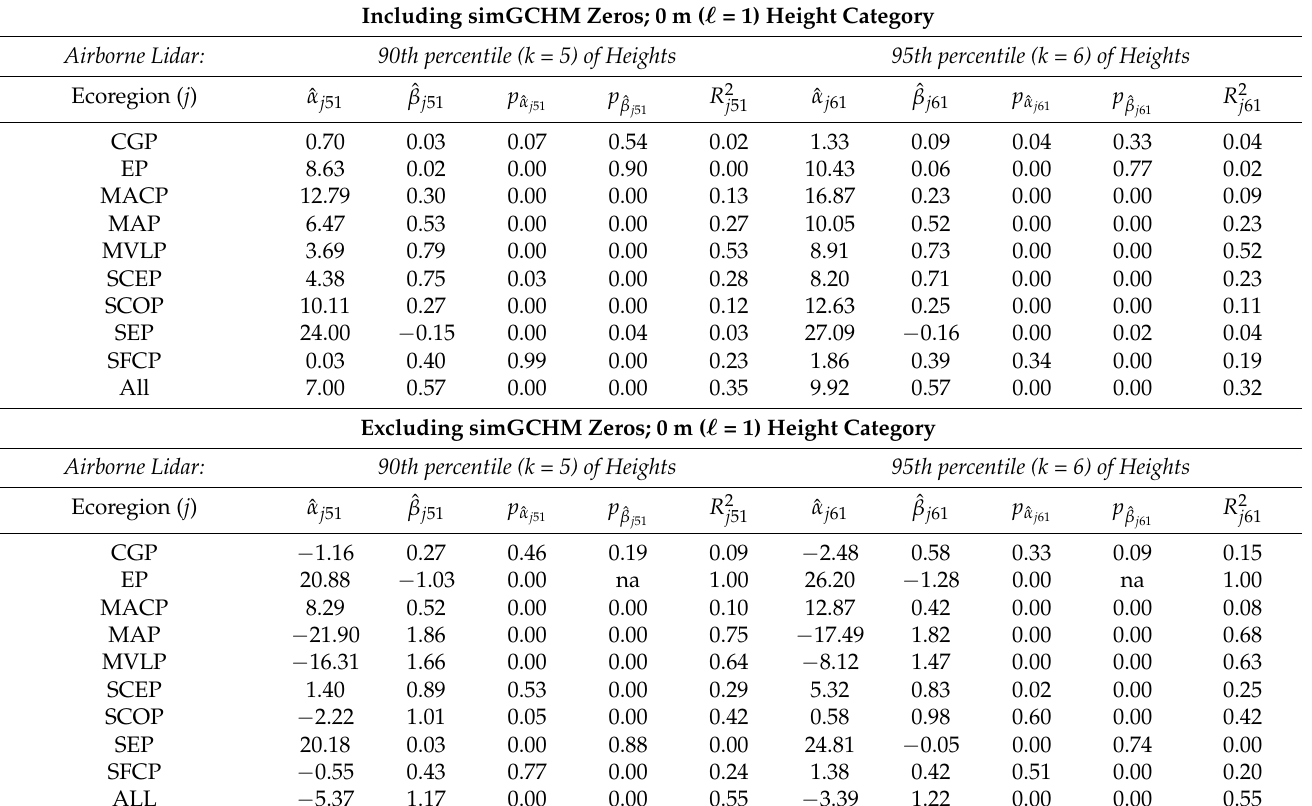
Table 4. Regression coefficient estimates and associated basic statistics for regressions, including (upper panel) and excluding (lower panel) simGCHM zero height values. Values to the left/right are for the 90th and 95th airborne lidar height percentiles; all regressions are for the 0 m airborne lidar height